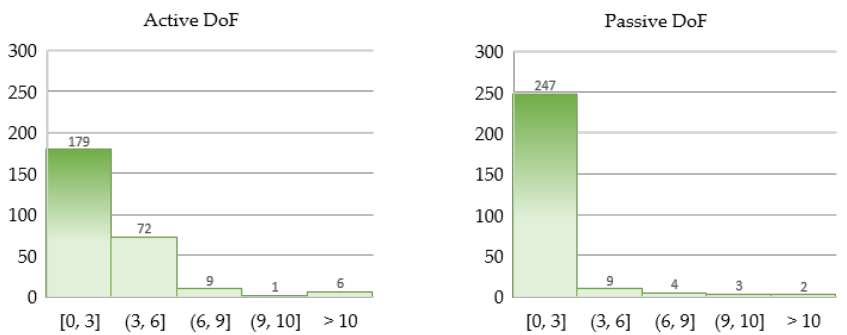
Figure 13. The distribution of exoskeletons active and passive DoF. A limited number of degrees of freedom is preferred both in the case of active and passive ones, but for the active ones, devices are more frequent with DoF between 3 and